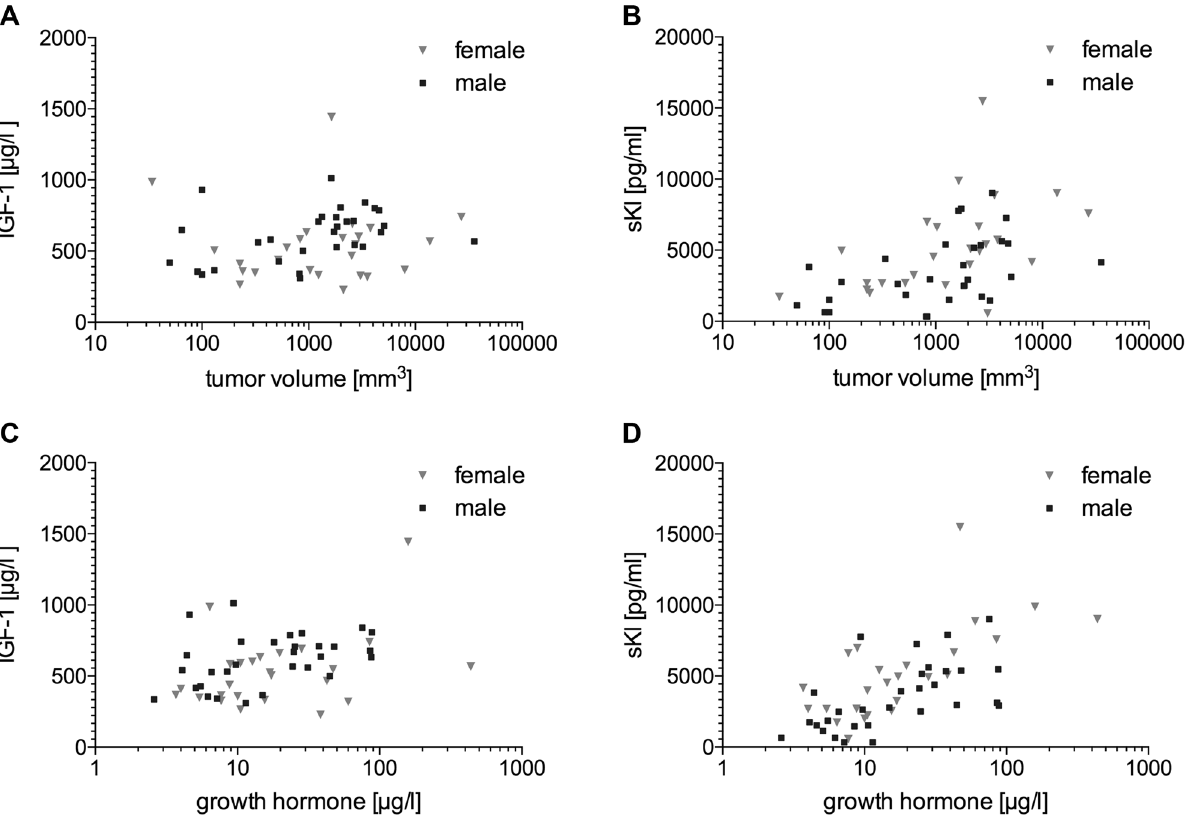
Figure 2. Scatter plots showing the correlation between preoperative values of ( A ) tumor volume (log scale) and insulin-like growth factor 1 (IGF-1, linear scale), r = 0.276, p = 0.041; ( B ) tumor volume (log scale) and soluble α-Klotho protein (sKl, linear scale), r = 0.527, p < 0.001; ( C ) growth hormone (GH, log scale) and IGF-1 (linear scale), r = 0.368, p = 0.006; ( D ) GH (log scale) and sKl (linear scale), r = 0.661, p < 0.001; Females are represented by grey triangles and males are shown as black squares. The correlation coefficient r and the p value were calculated according to